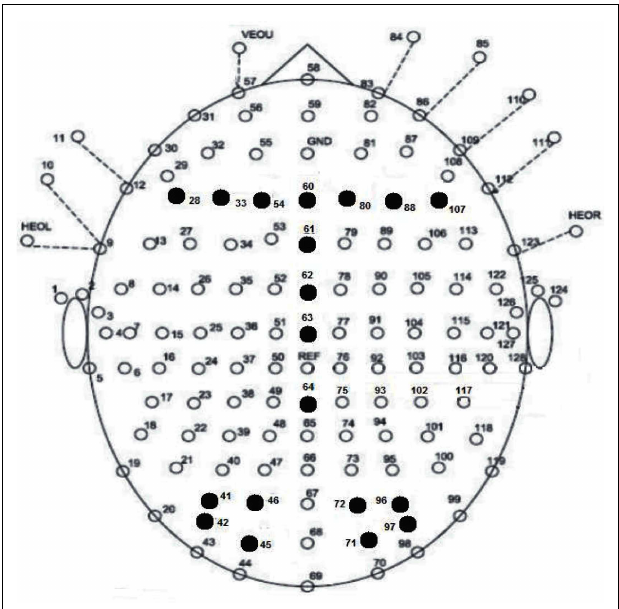
FIGURE 1 |Topographic plot of electrode array (128 NSL Quikcap) with electrodes filled in black used in statistical